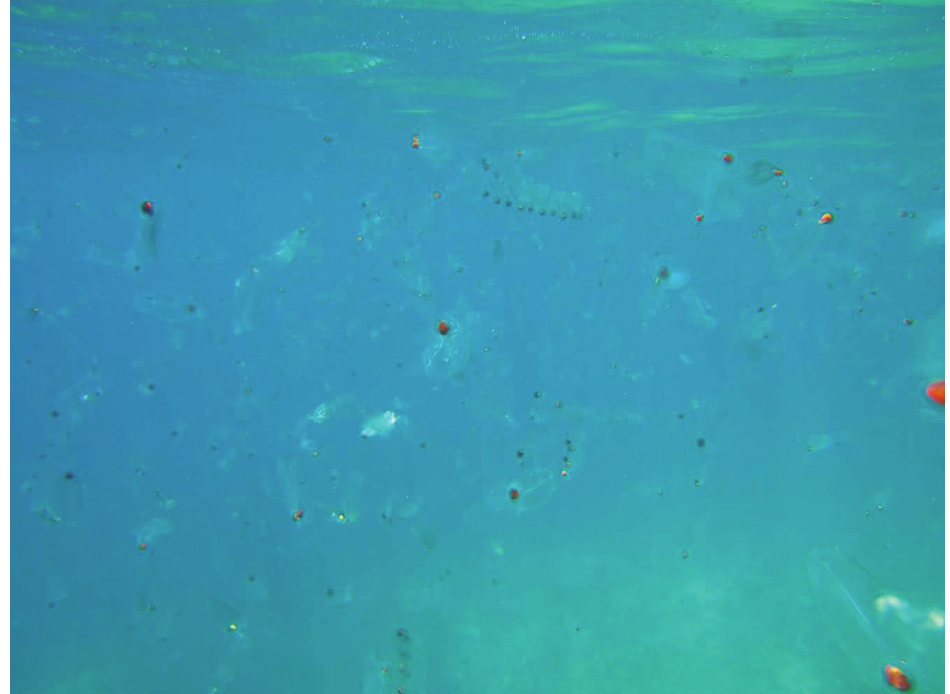
Figure 3. The fragments of salp chains, at the end of the bloom. Picture by S. Fraschetti.